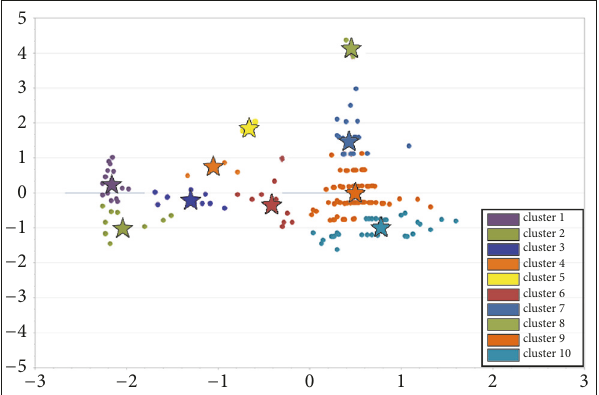
Figure 9: Result of synchronous clustering (Sync)